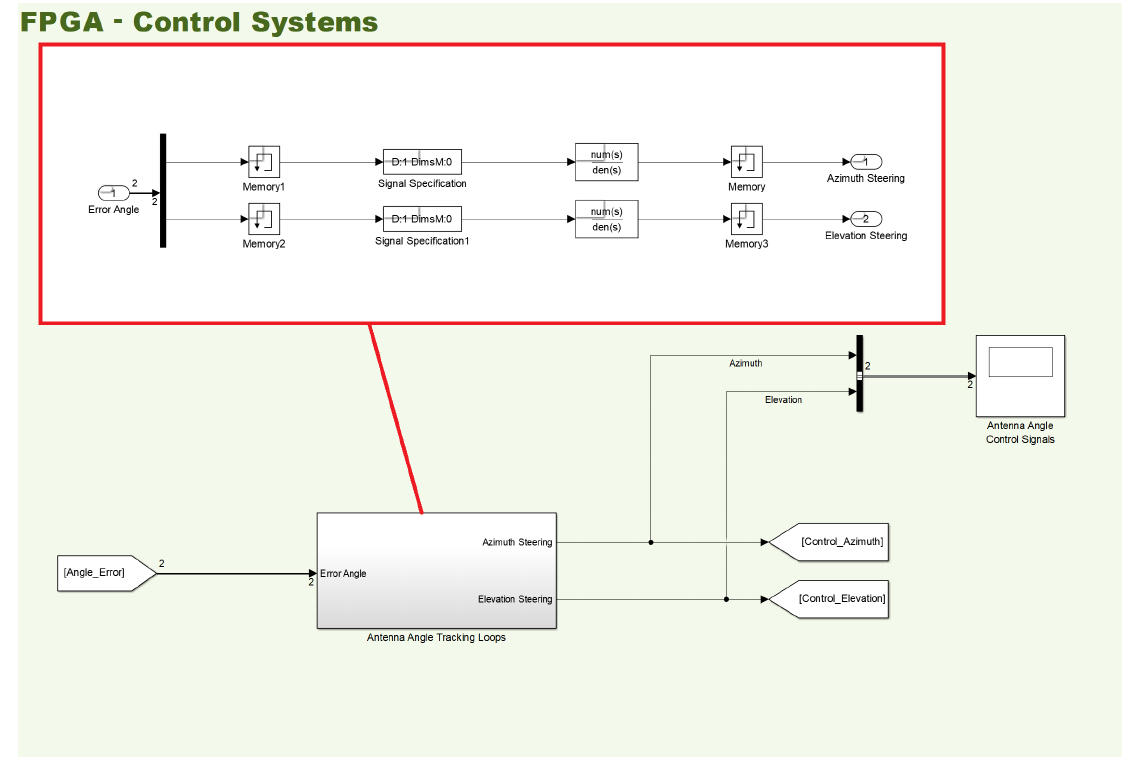
Figure 15. The Simulink model that takes the angle error signals in azimuth and elevation and, using a tracking loop, updates the estimate of the target position for the